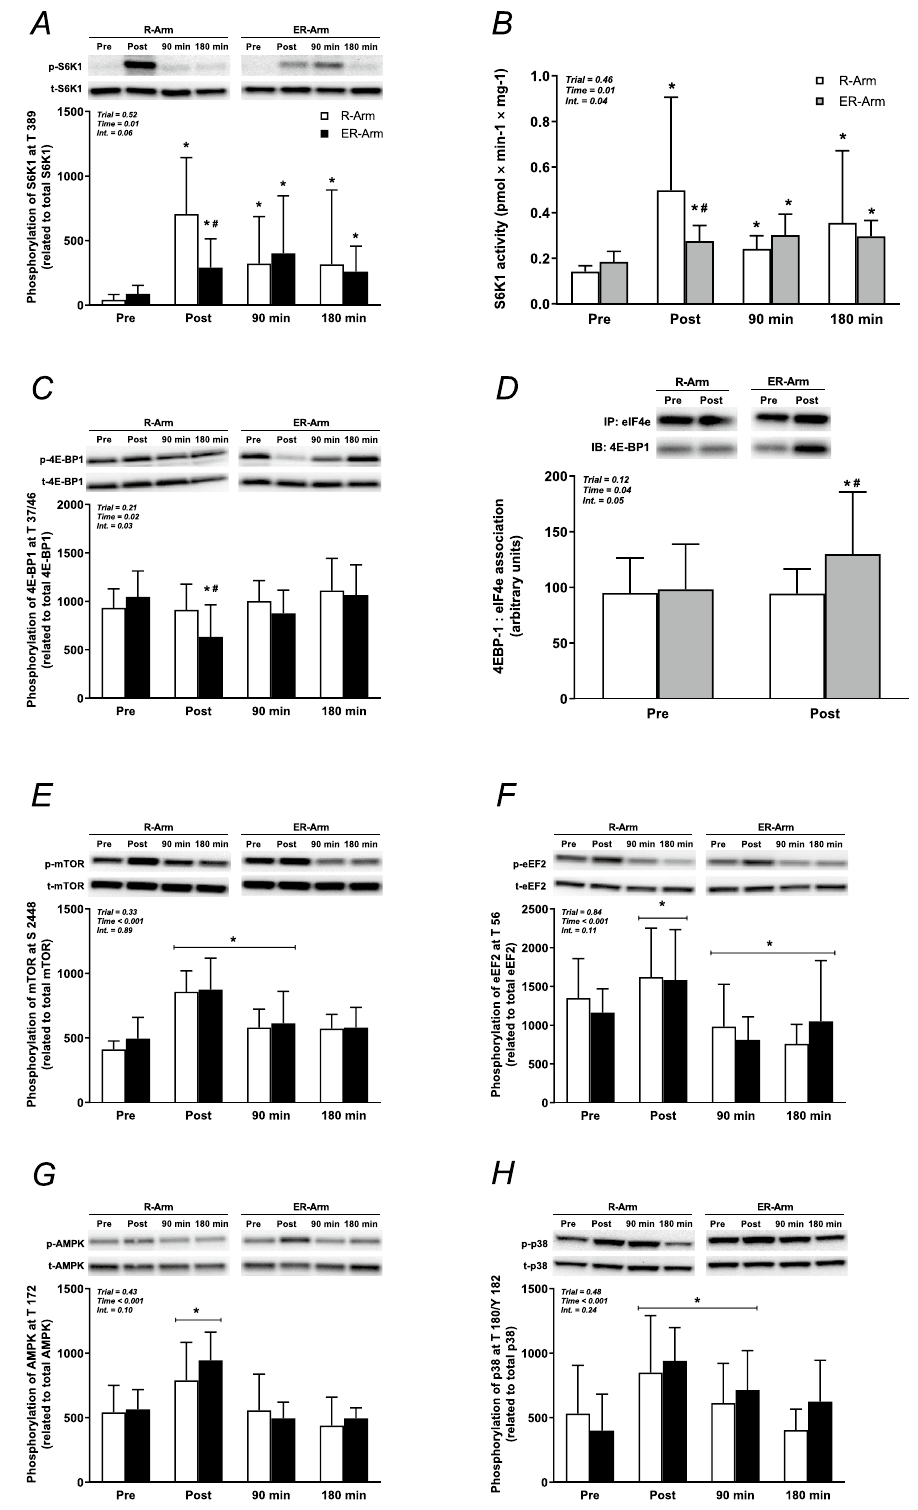
Figure 4. Phosphorylation of S6K1 at Thr 389 ( A ), kinase activity of S6K1 ( B ), phosphorylation of 4E-BP1 at Thr 37/46 ( C ), the total amount of 4E-BP1 immuoprecipitated together with eIF4E ( D ), phosphorylation of mTOR at Ser 2448 ( E ), eEF2 at Thr 56 ( F ), AMPK at Thr 172 ( G ) and p38 at Thr 180 /Tyr 182 ( H ) at different stages of both trials. The values presented are means ± SD for 8 subjects. * P < 0.05 vs. Rest, # P < 0.05 vs. the R-Arm trial. Symbols denoted with a line represent a main effect. Symbols without a line represent an interaction effect with corresponding significant differences in the post-hoc analysis. Representative immunoblots (from strips of full-length blots) of both phosphorylated (upper panel, except for IP) and total protein (lower panel) from one subject are shown above each graph. The two sets of bands have been rearranged, and separated with a white space, to fit the order of the trials in the graphs. Pre = baseline, Post = immediately after exercise, 90 and 180 min = length of